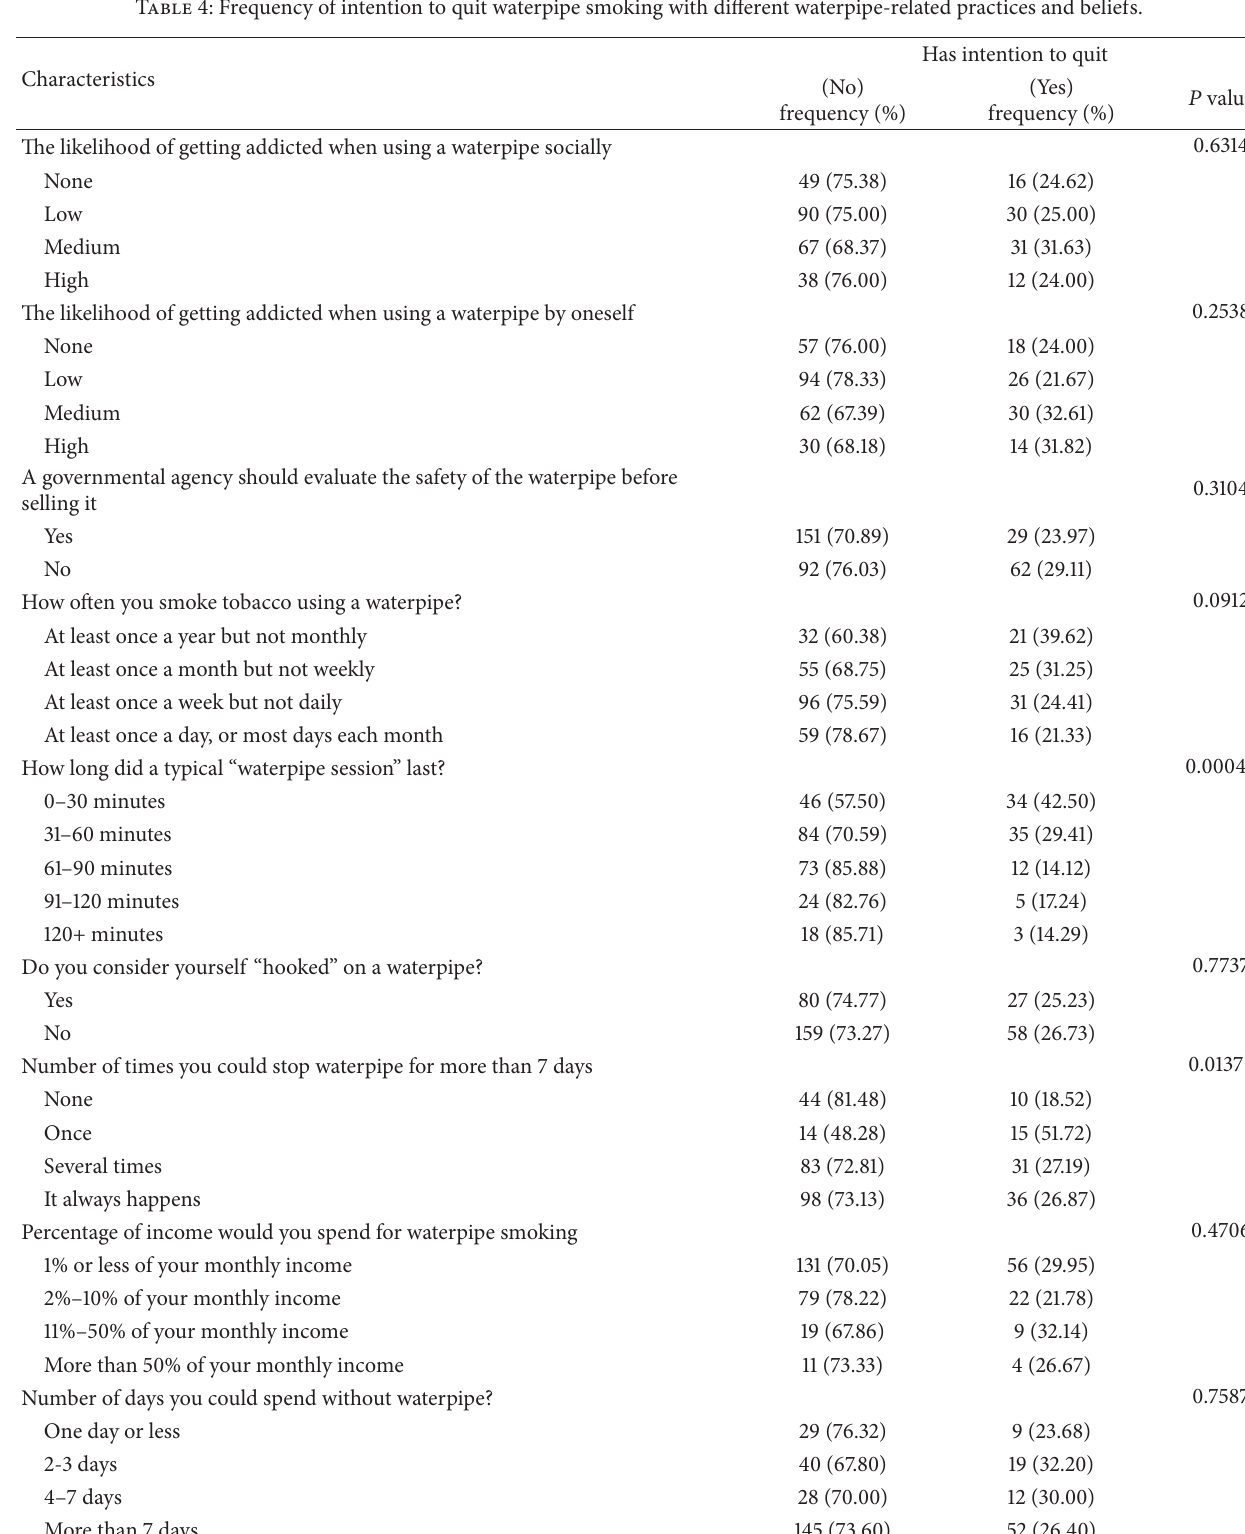
Table 4: Frequency of intention to quit waterpipe smoking with different waterpipe-related practices and